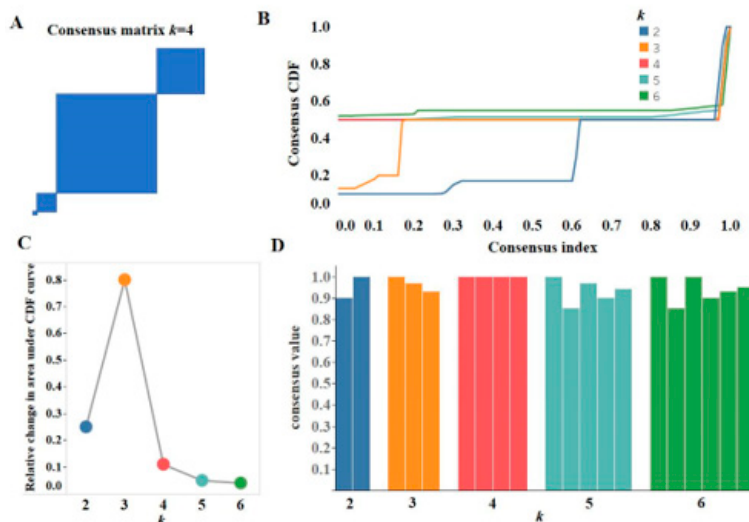
Figure 6. Consensus clustering method with bi-kmeans results.